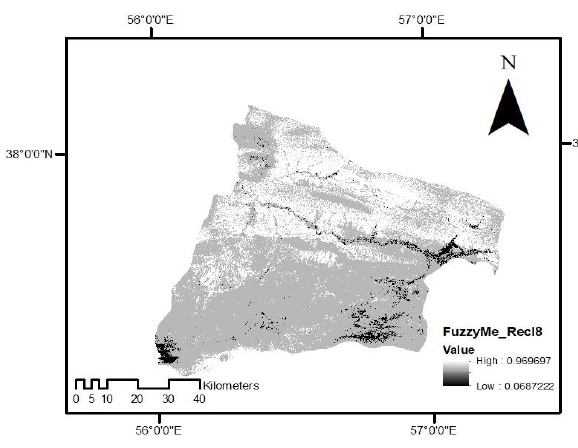
Figure 9. Using Large membership function for NDVI layer Potential flood risk map was generated by Gamma fuzzy overlay with Gamma equal to 0.85 and classified into five categories: